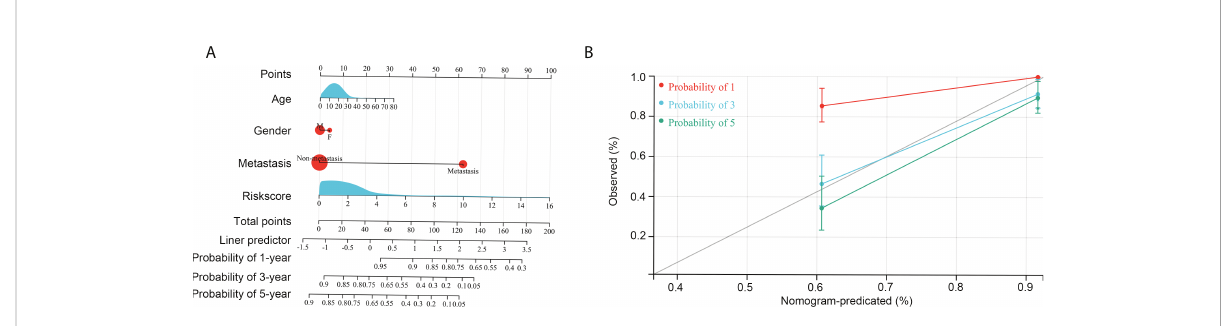
FIGURE 7 Construction of the nomogram. (A) Age, gender, risk score, and metastasis was used to construct the nomogram. (B) Ef fi ciency of the nomogram in the 1-year, 3-year, and 5-year survival rates of patients with OS.